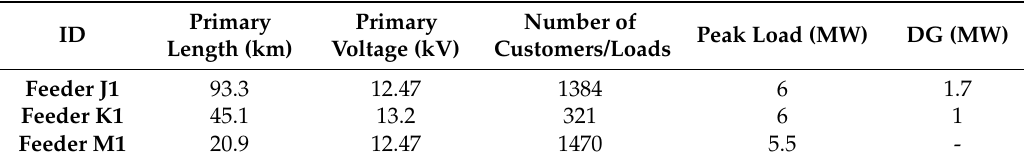
Table 3. The Electric Power Research Institute (EPRI) Test Feeders 1.